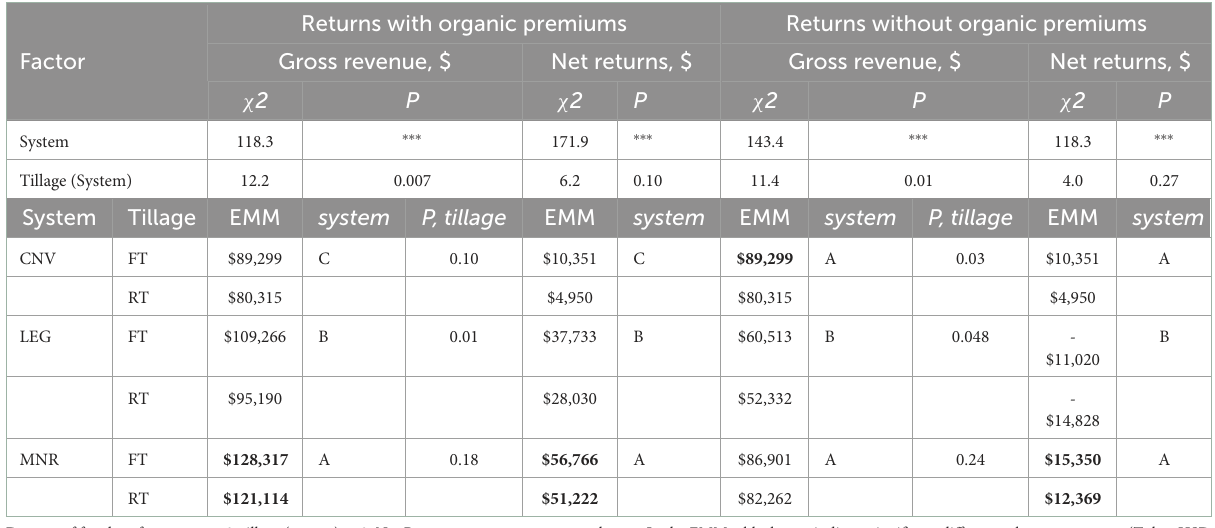
TABLE 3 ANOVA tables and estimated marginal mean values (EMM) for differences in annual gross revenue and net returns for representative farms with different tillage × system treatments, with tillage nested in system and denoted as tillage (system). Returns with organic premiums Returns without organic premiums